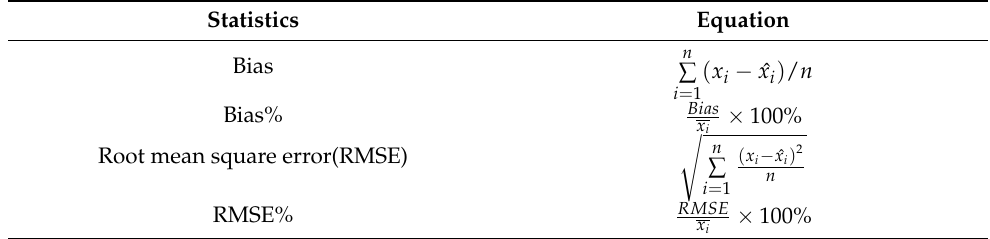
Table 5. Accuracy of BPLS and field